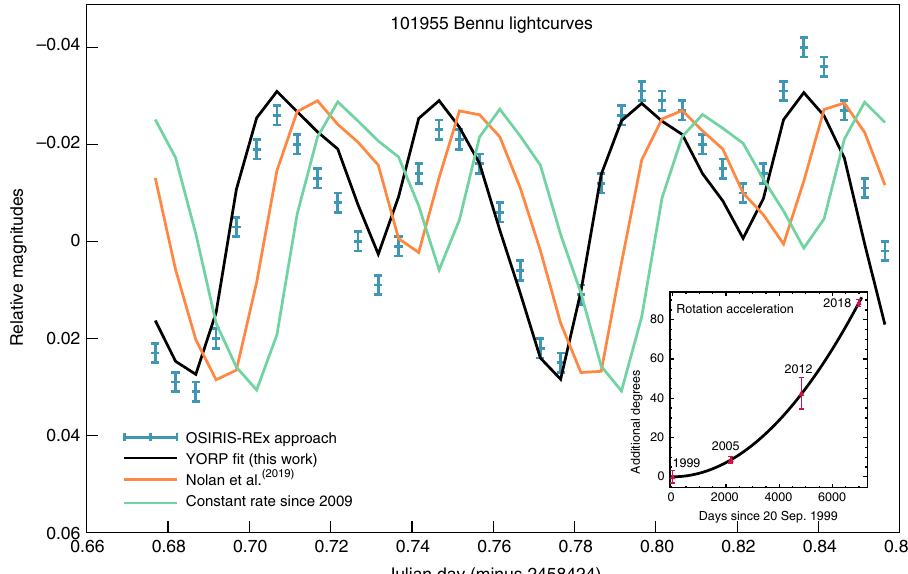
Fig. 4 Lightcurve data and models for Bennu on 2 November 2018. The blue crosses are the OSIRIS-REx observations with their associated 1-sigma photometric uncertainties. The black curve (best fi t to peaks and minima) shows the YORP acceleration determined from fi tting the Approach phase observations with 1-sigma uncertainties. The orange lightcurve using the previously reported acceleration value 34 does not fi t as well as the black curve. The green curve assumes a constant rotation rate since 2009. The inset plot shows the quadratic increase of rotation phase with time, consistent with rotational acceleration due to YORP. Source data are provided as a Source Data fi Centaur population. The goal of this method is to estimate the total mass of a possible coma from light measured using photometry of an annulus between two circular apertures. We also estimate the approximate time that dust would remain in the given annulus. Dividing these two quantities provides us with a mass loss rate. A median co-add of images from the Dust Search campaign was created, and then two photometry measurements of Bennu at radii of 20 and 30 arcseconds were measured. The IRAF phot package was used to determine instrumental magnitude of these apertures. We also corrected for sections of the point spread function leaking into the coma annulus as suggested in ref. 38 . These magnitudes were transformed into a R-band magnitude system where the apparent magnitude of the Sun is known (for Eq. 3). Equations 1, 3, and A4 in ref. 38 were used to calculate the bound mass in the annulus between the two photometric apertures. Phase angle, Bennu-Sun distance, and Bennu-OSIRIS-REx distances were calculated from Bennu ’ s ephemeris using